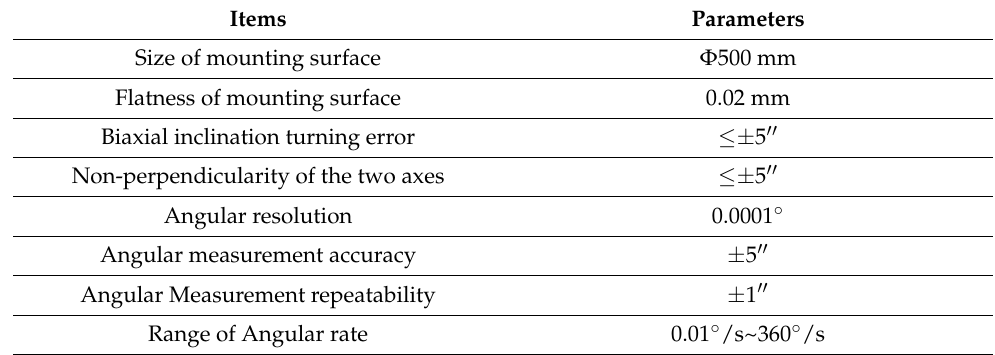
Figure 11. The calibration experiments. Table 4. The performance parameter of the three-axis turntable.